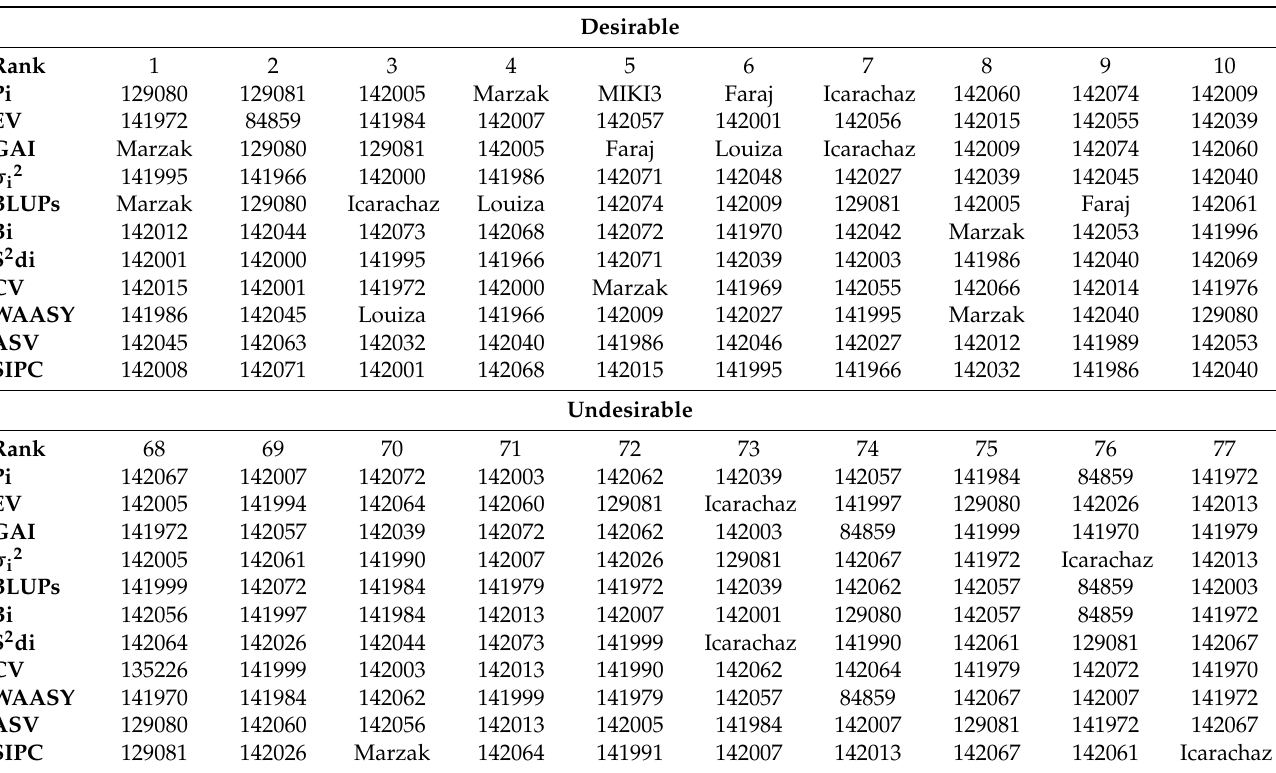
Table 6. Ranking of the best ten stable and the least ten stable genotypes of durum wheat genotypes using parametric stability